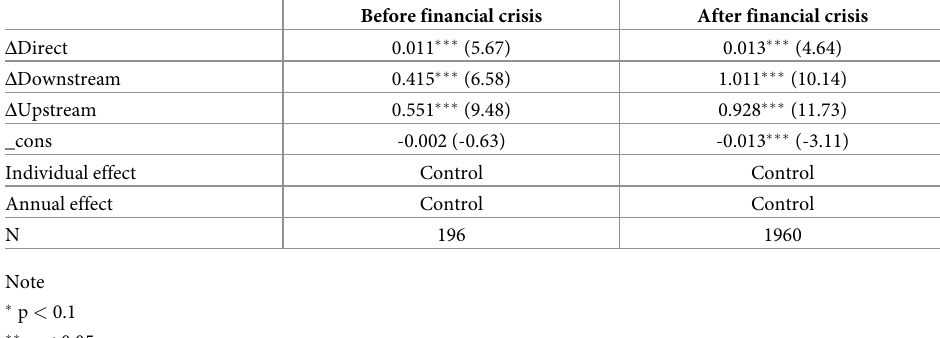
Table 3, the empirical regression results of three major effects of all six major producer service sectors are basically consistent with the benchmark regression results of the overall samples, but showing obvious differences in size. In terms of direct effect, financial services have the highest degree of promoting the domestic value added in exports of manufacturing (0.232), but communication services and insurance services have no significant impact. In terms of upstream effect, the impacts of the six departments are all positive, among which the computer and information services have the greatest promotion effect (1.236) because of their impact on production factors and production functions. In terms of downstream effect, there is a big gap between the downstream manufacturing industry and the insurance service, while the Finan- cial service and communication service are relatively small (0.841 and 0.622). (II) Heterogeneity analysis before and after the financial crisis The time span of data is from 2007 to 2017. Therefore, the global financial crisis in 2008 is selected as the division point to investigate the heterogeneity of industrial relevance effect of imports of producer services before and after the financial crisis. As shown in Table 4, after the Table 4. Heterogeneity analysis result before and after the financial